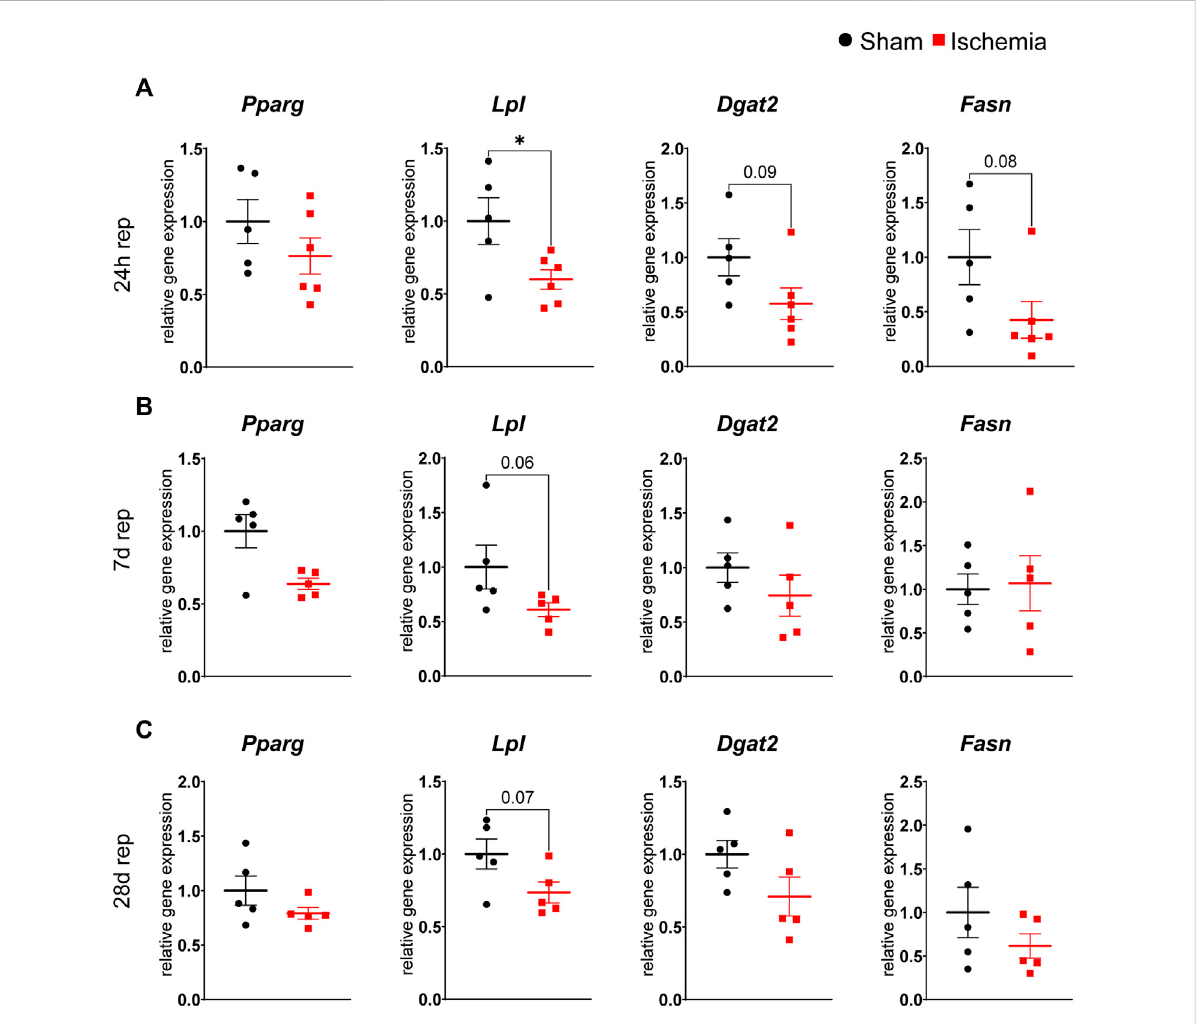
FIGURE 4 Reduced lipogenesis in iWAT after cardiac I/R Relative gene expression of Pparg , Lpl , Dgat2 and Fasn in iWAT after 24 h (A) , 7 days (B) and 28 days (C) of reperfusion. n = 5 – 6, data are mean± SEM, Mann-Whitney test or unpaired, two-tailed t -test were used, * p <